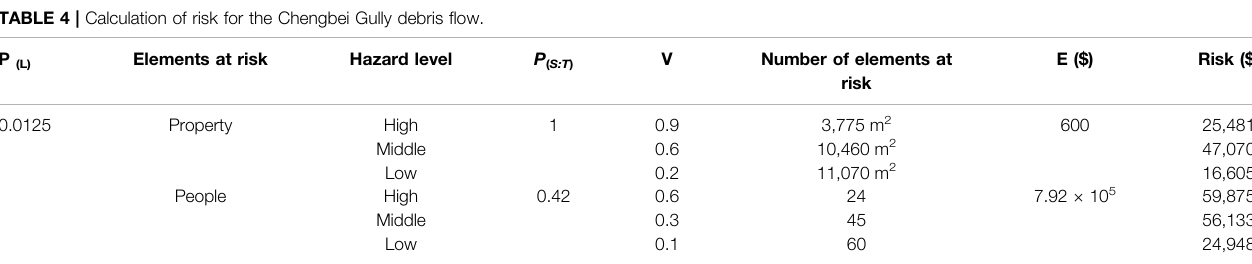
TABLE 4 | Calculation of risk for the Chengbei Gully debris fl